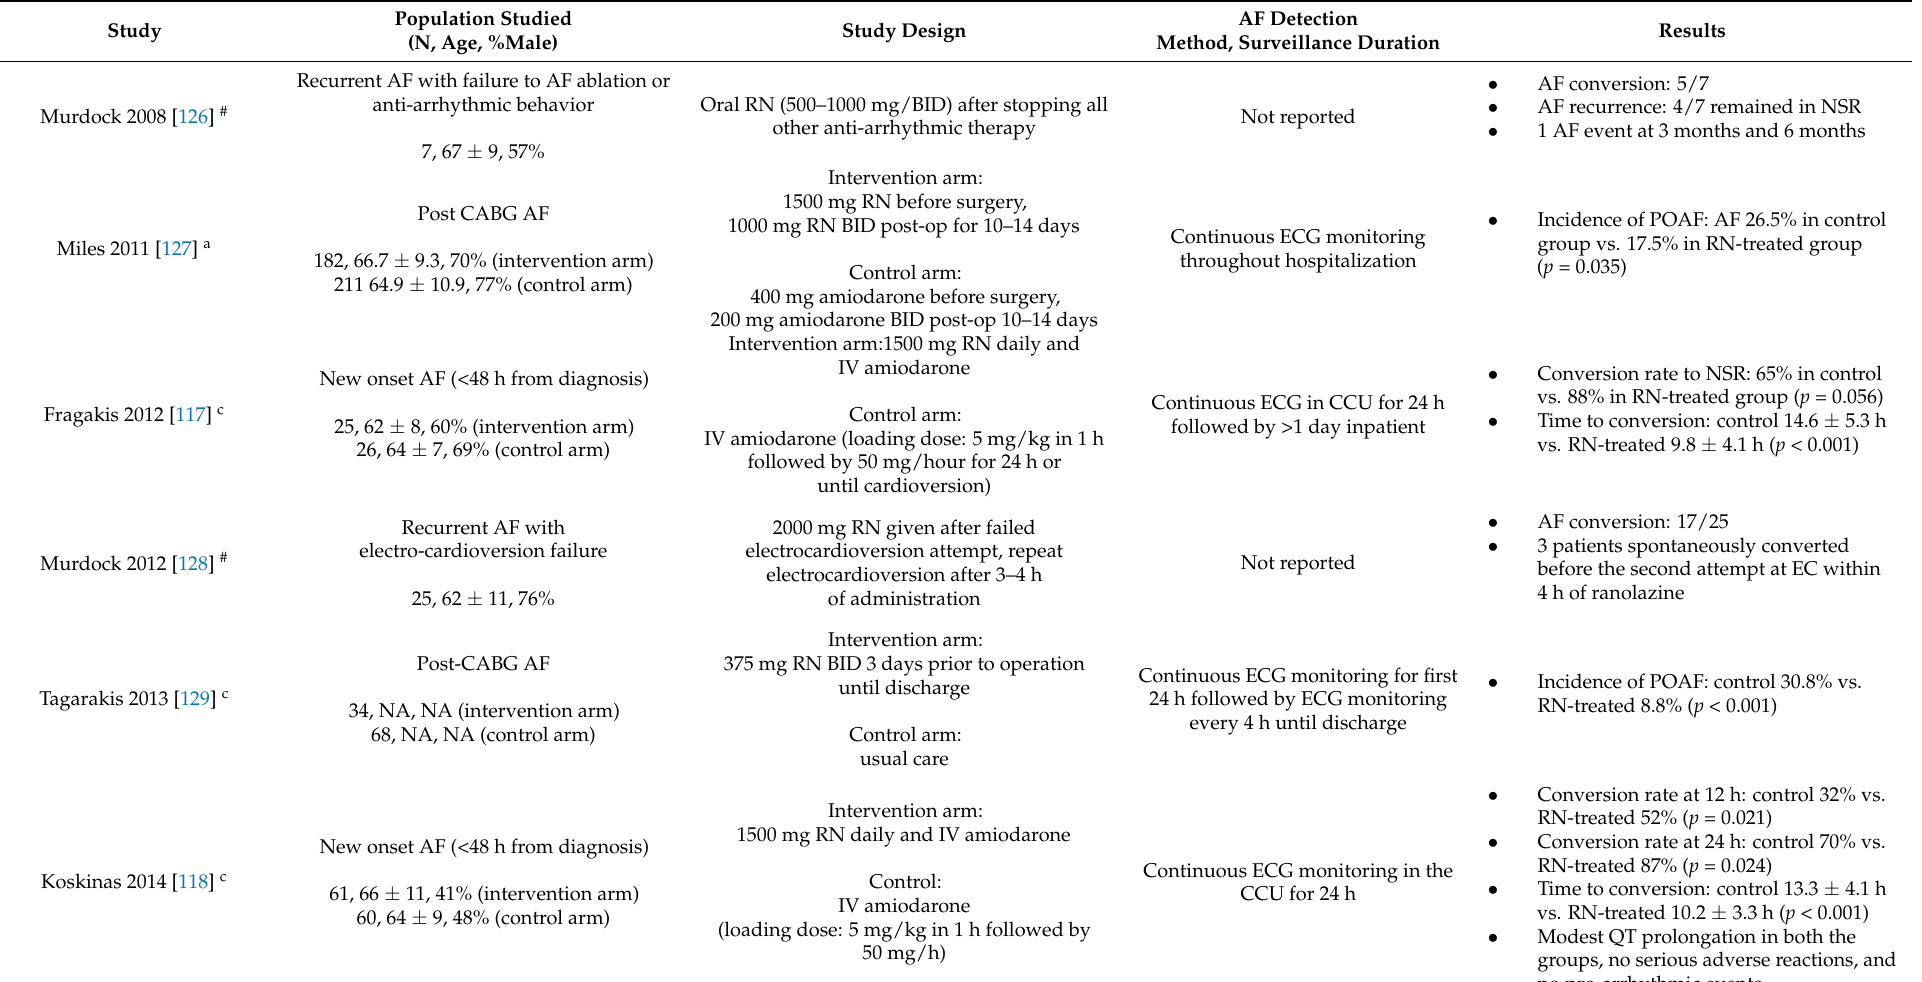
Table 1. Clinical studies testing ranolazine for AF